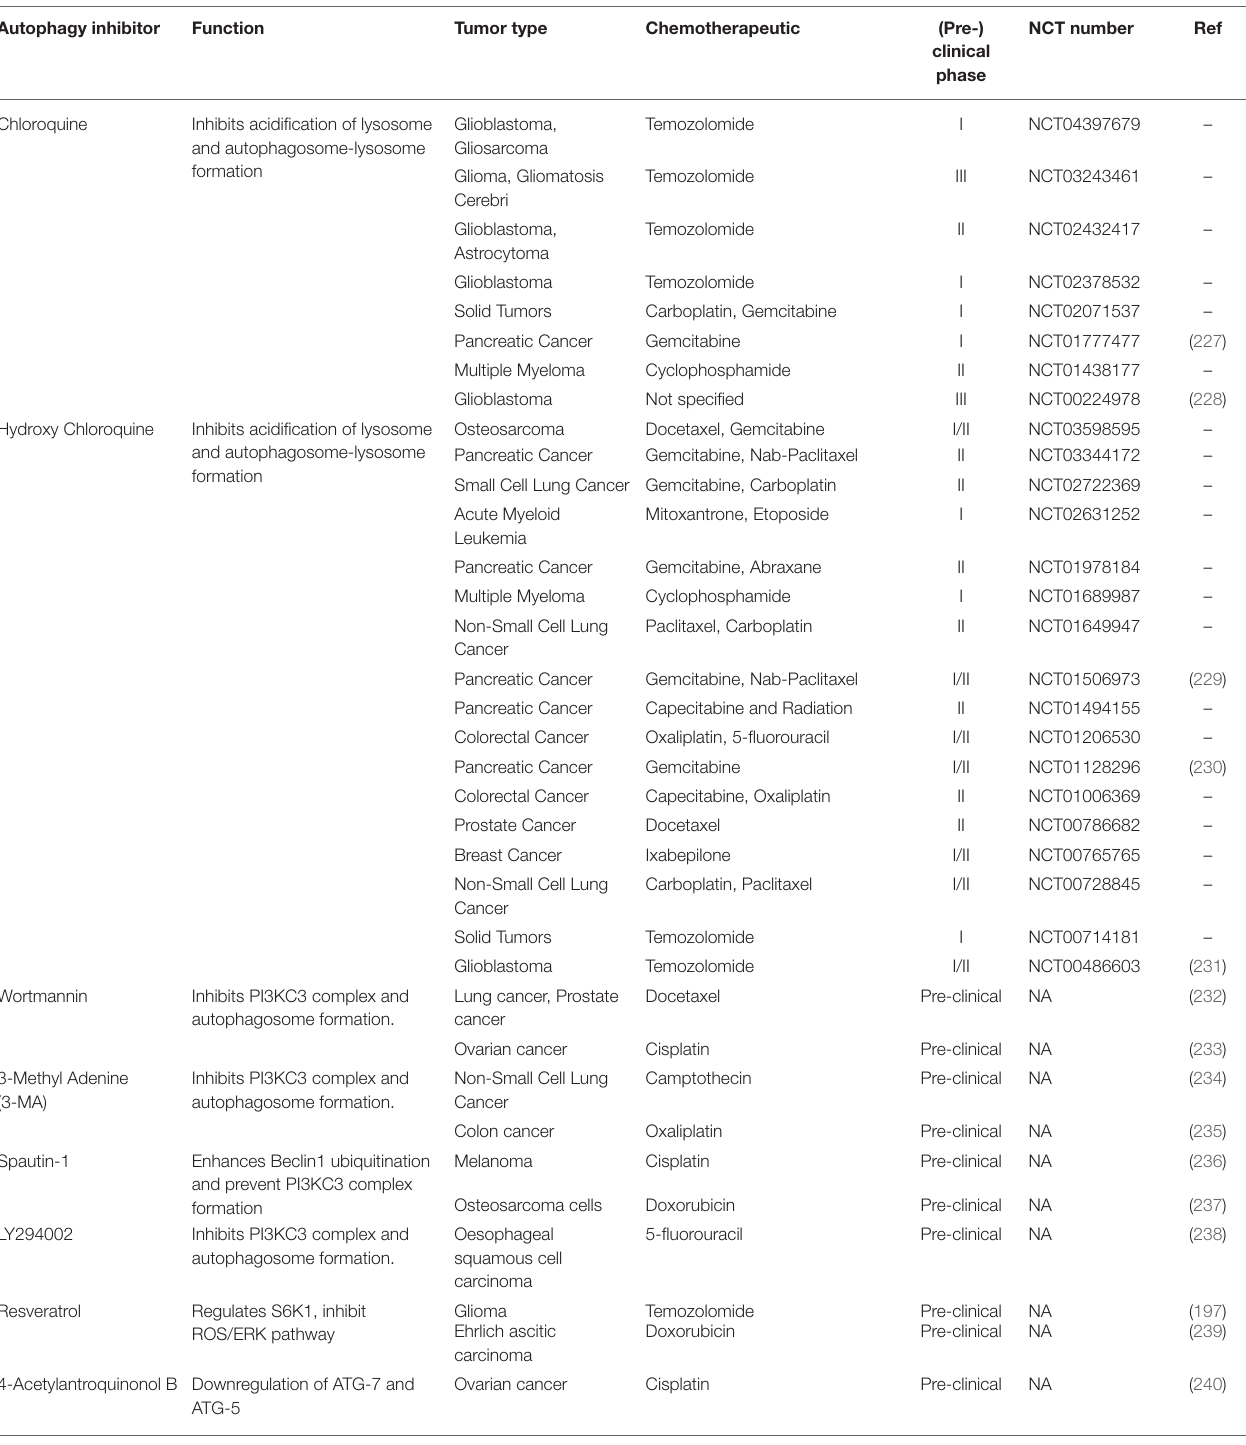
TABLE 1 | Anticancer drugs that inhibit autophagy used in combination with